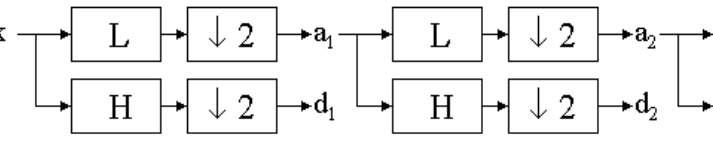
Figure 3. The discrete wavelet transform tree.